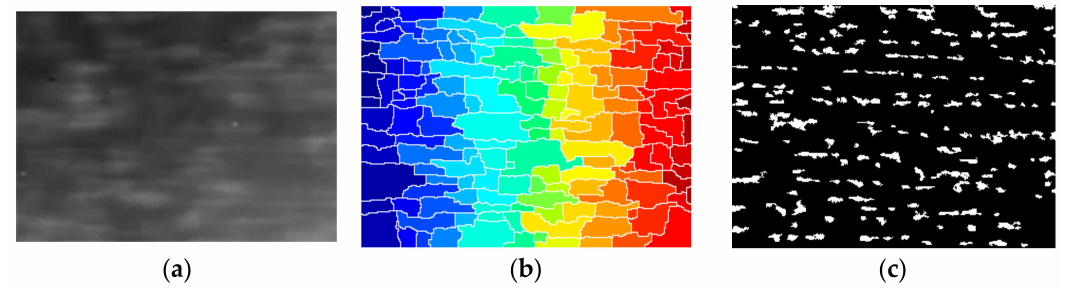
Figure 2. Trough extractions. ( a ) Original image. ( b ) Region segmentation. ( c ) Trough